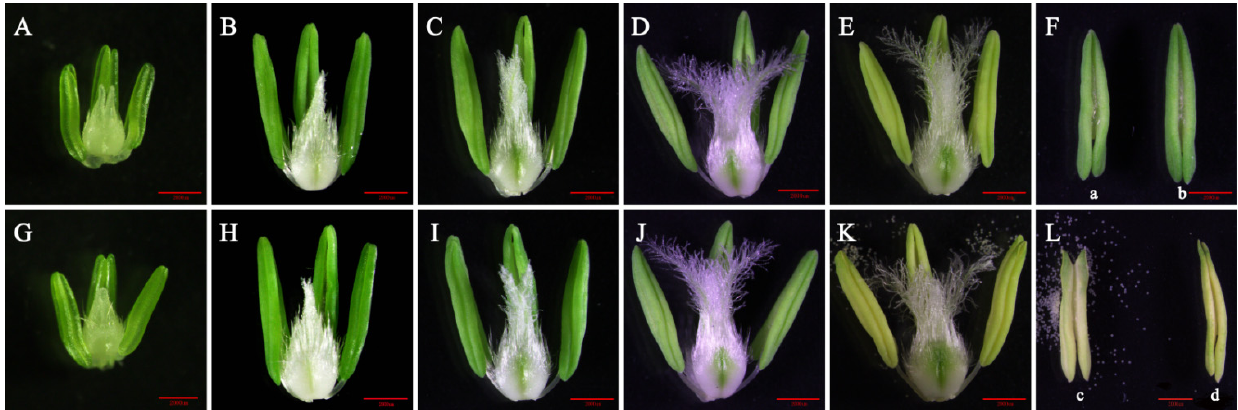
Figure 1. Phenotypes of wheat anthers at five stages of development in the B-type CMS line ( A – E ) and its maintainer line ( G – K ). ( A , G ) Tetrad stage; ( B , H ) early-uninucleate stage; ( C , I ) later-uninucleate stage; ( D , J ) binucleate stage; ( E , K ) trinucleate stage; ( F ) binucleate stage, where ‘a’ is the single B anther and ‘b’ the single YS9 anther; and ( L ) trinucleate stage, where ‘c’ is the single YS9 anther, and ‘d’ the single B anther. Scale bars are 2 mm (2000 µm).